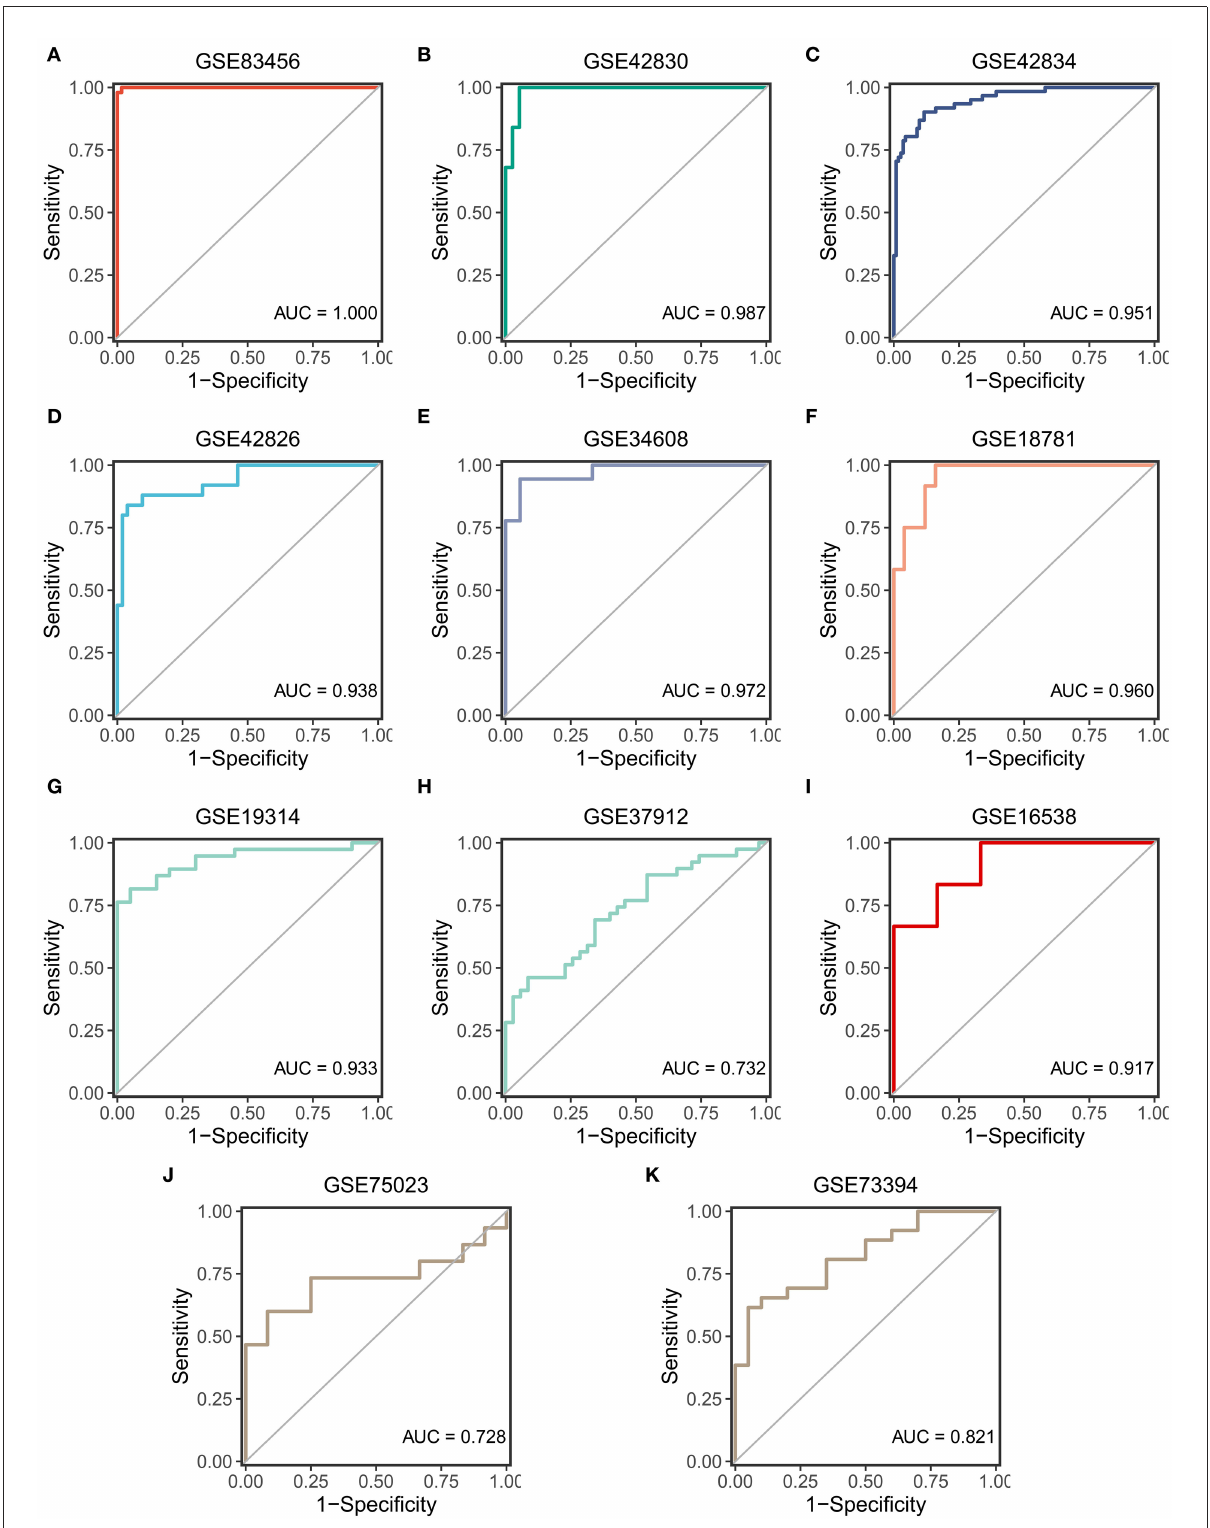
FIGURE6 The validation of the SARDS in 11 cohorts. (A) The ROC curve of the modeling dataset (GSE83456). (B–K) The ROC curves of validation datasets (GSE42830, GSE42834, GSE42826, GSE34608, GSE18781, GSE19314, GSE37912, GSE16538, GSE75023, and